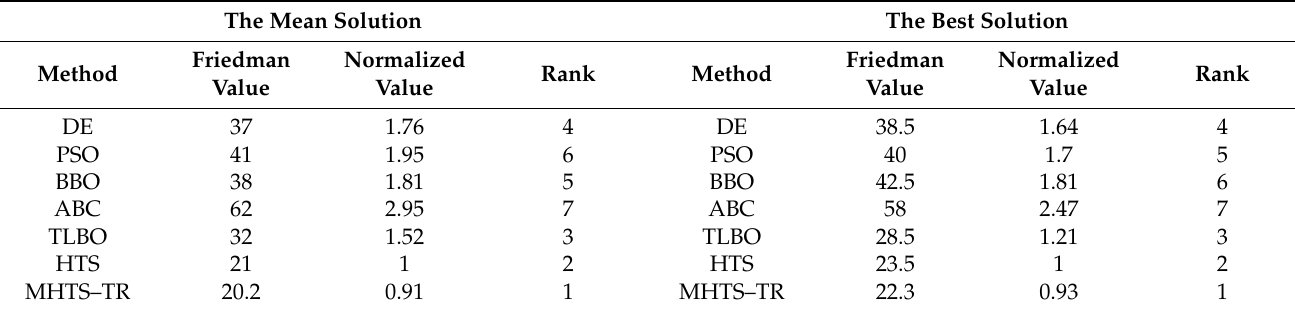
Table 5. Friedman rank of C14–C24 for the solutions obtained by the MHTS–TR and other MHAs. (The experimental results of the competitors are derived from the literature